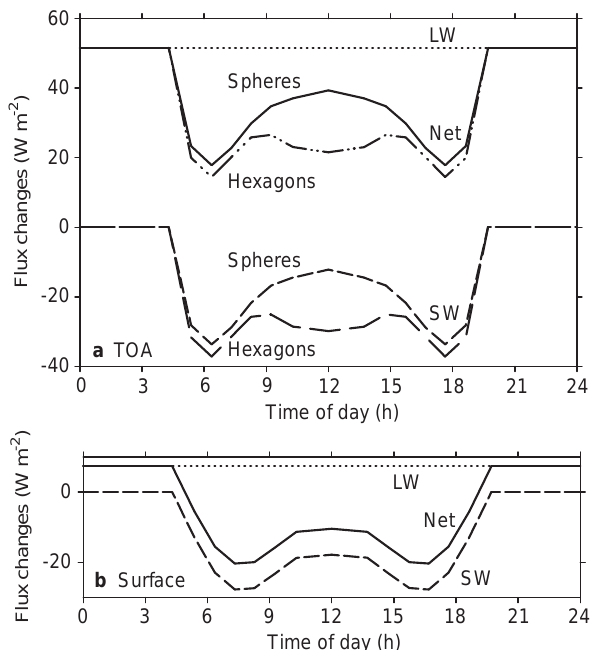
Fig. 4a, b. Flux changes a at top of atmosphere (TOA) and b at the surface versus time of day for shortwave ( SW ), longwave ( LW ), and net ( SW + LW ) fluxes for spherical and hexagonal (shown for TOA only) particles in a contrail with optical depth of 0.52,